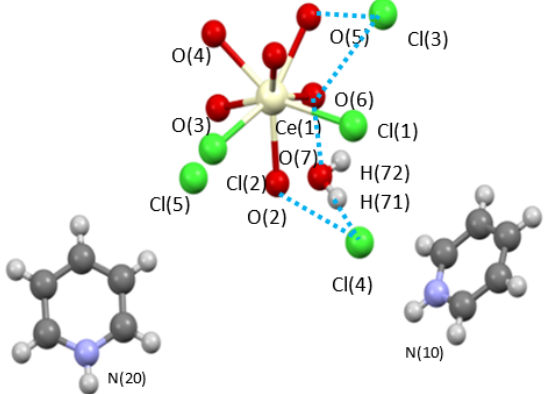
Figure 1. Ball and stick structure plot of [Ce(Cl) 2 (OH 2 ) 6 ][py ‐ H] 2 [Cl] 3 ( H 2 O) ( Ce ‐ H 2 O/py ‐ H ). Blue dashed line represents H ‐ bonding. dashed line represents